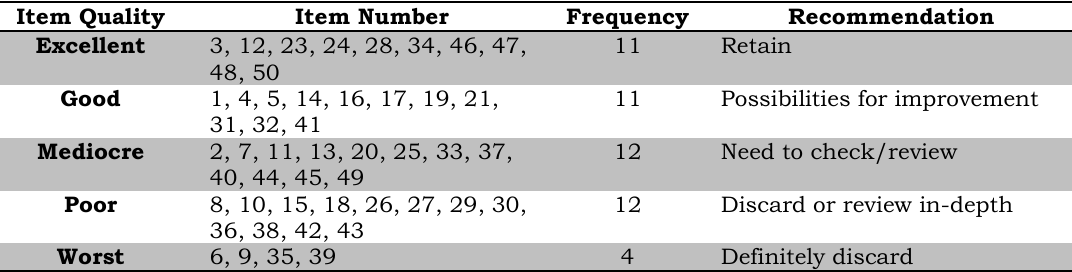
Table 5. The Interpretation of Discriminating